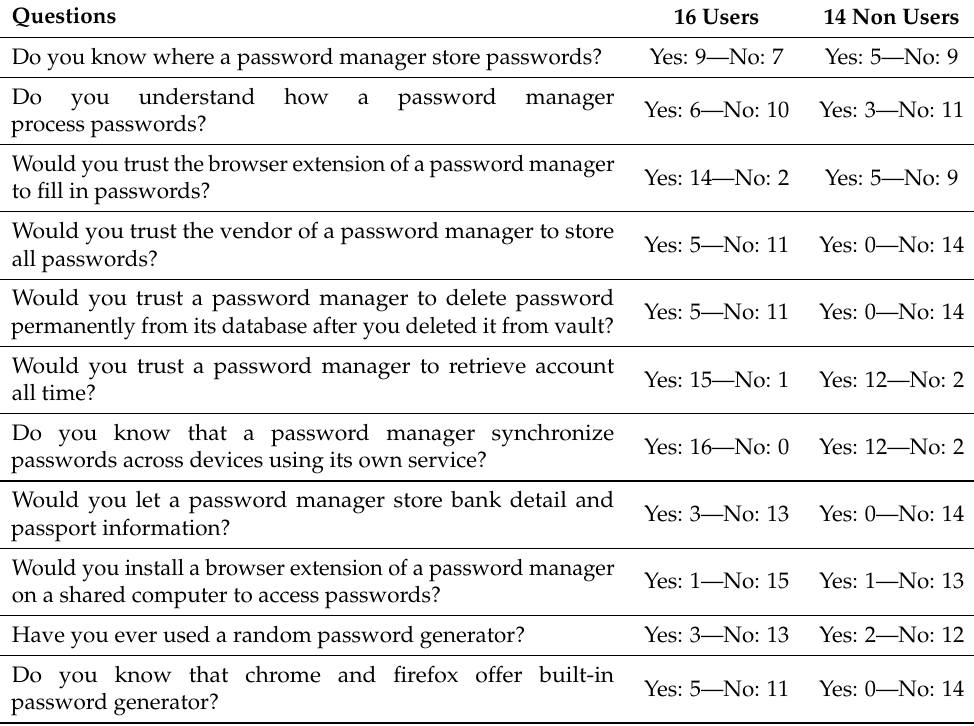
Table 12. Answers by 16 users and 14 non-users for (Yes/No) questions about password managers and the similarities between the two